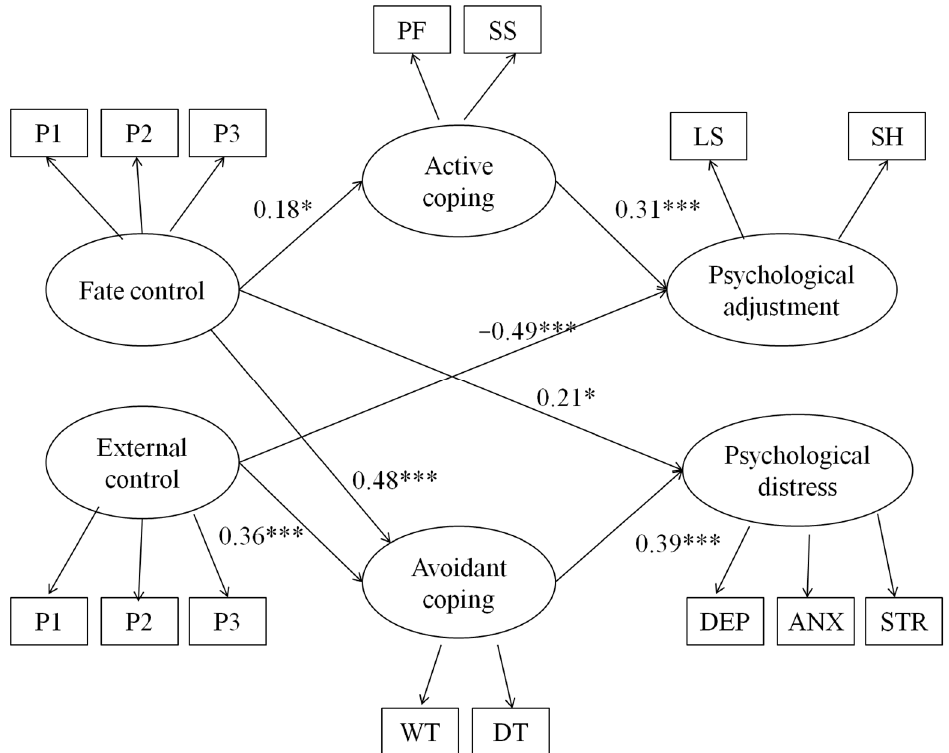
Figure 1. Structural equation model with standardized coefficients in Study 1. PF = problem-focused coping; SS = seeking social support; WT = wishful thinking; DT = distancing; SH = subjective happiness; LS = life satisfaction; DEP = depression; ANX = anxiety; STR = stress. All paths were tested. Only significant paths are shown. * p < 0.05, ** p < 0.01, *** p < 0.001.